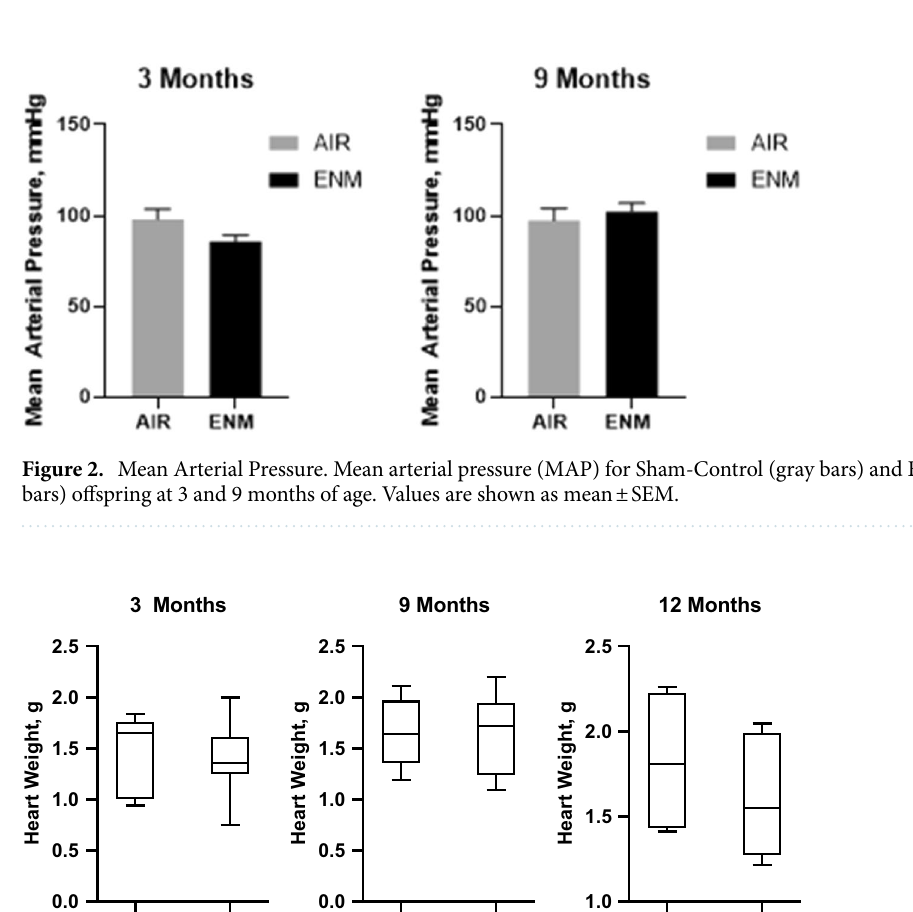
Figure 1. Body weight. Interval body weight (mean ± SEM) versus Age (weeks) of offspring from Sham-Control and ENM groups. *Indicates p ≤ 0.05 versus Sham-Control (AIR) group.